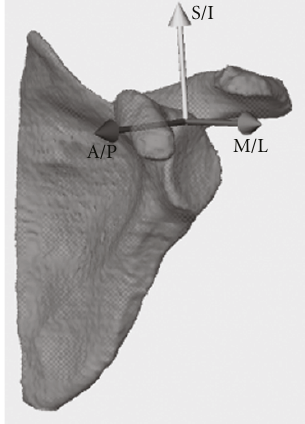
Figure 1: The contact center location was expressed relative to a subject-specific scapula coordinate system. The axes of the scapula coordinate system are aligned in the anterior/posterior ( X axis), superior/inferior ( Y axis), and medial/lateral ( Z axis)